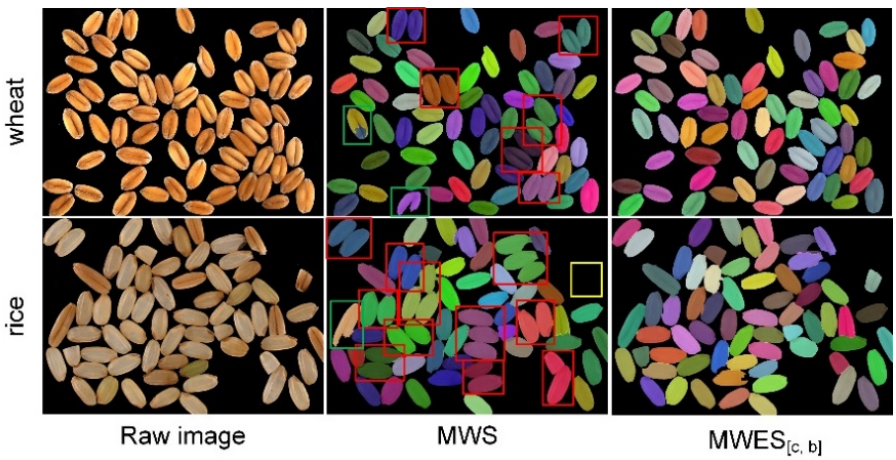
Figure 1. Segmentation examples of cereal grain images with MWS and MWES [c, b] .